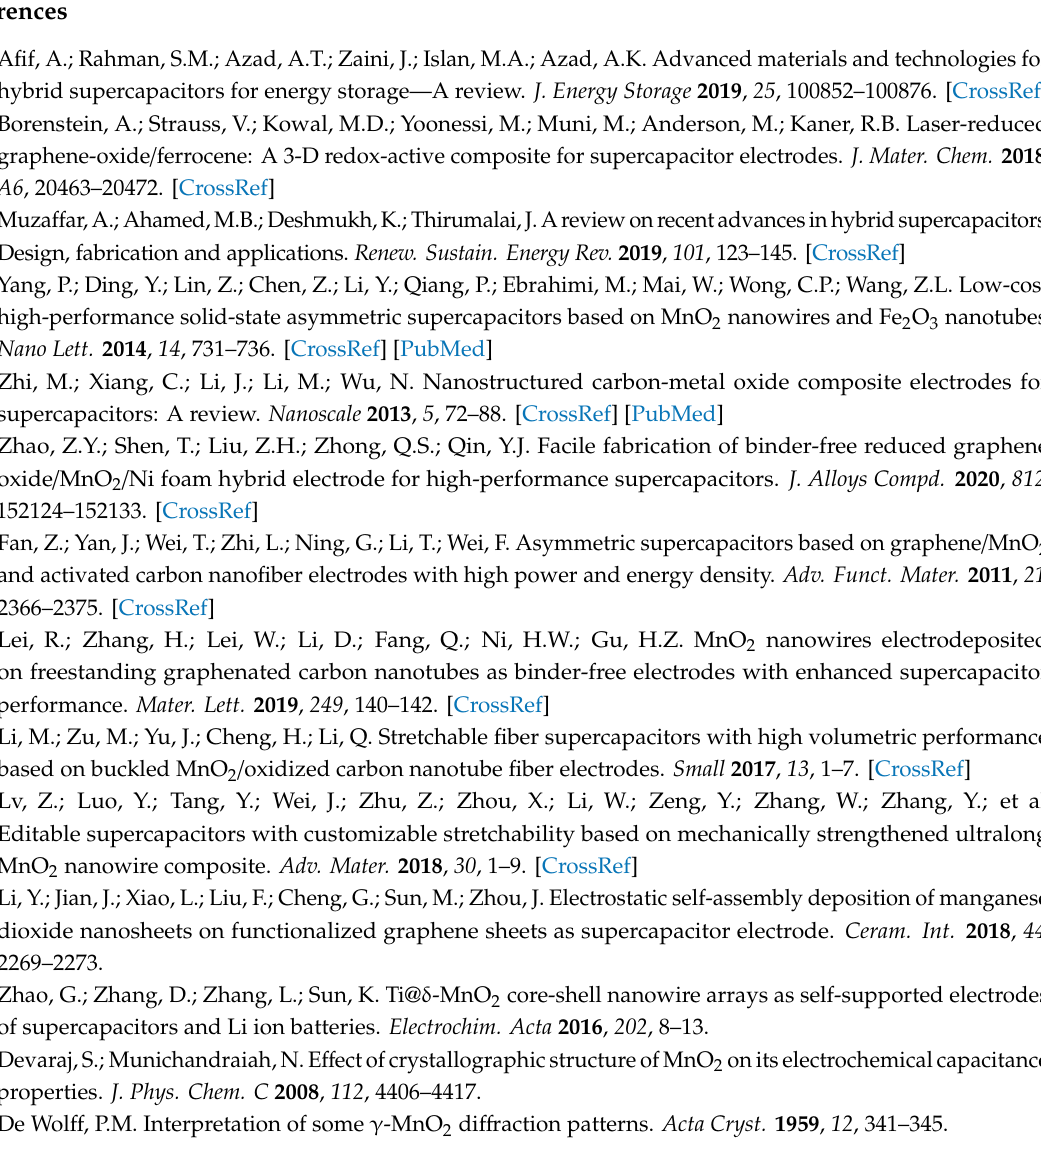
s1, Figure S1: Properties of the as-obtained materials; Figure S2: Material properties and electrochemical characterization of the as-obtained MnO 2 from di ff erent concentrations of MnSO 4 ; Figure S3: FESEM images for the as-obtained MnO 2 -based / NF